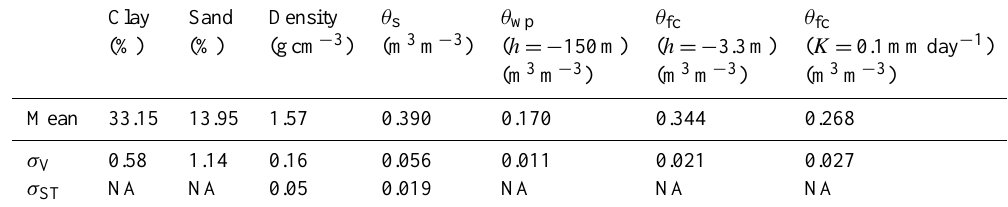
Table 2. Mean soil properties over the 0–1.2m soil profile. Density is the soil bulk density. θ s is the soil moisture at saturation derived from bulk density measurements. θ wp and θ fc are the soil moisture at wilting point and field capacity, respectively, derived from laboratory methods for given hydraulic conductivity ( K ) or matric potential ( h ) levels. The second and third rows represent the vertical ( σ V ) and the spatiotemporal ( σ ST ) variability of these measurements, respectively. NA means not available.